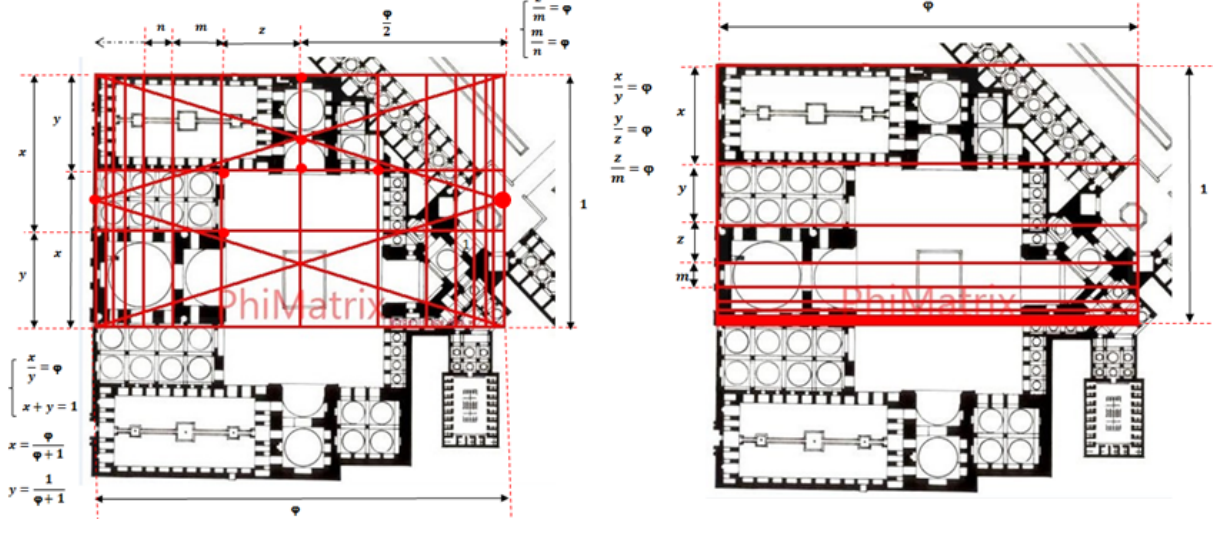
Figure 3: Adaptation of plan lines with golden distances in the northern frame